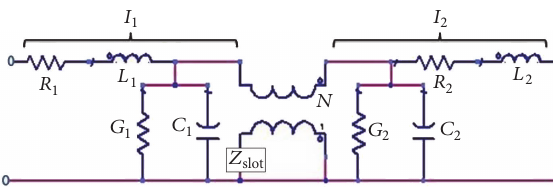
Figure 10: Equivalent circuit model for the microstrip antenna embedded with circular slot in the ground plane